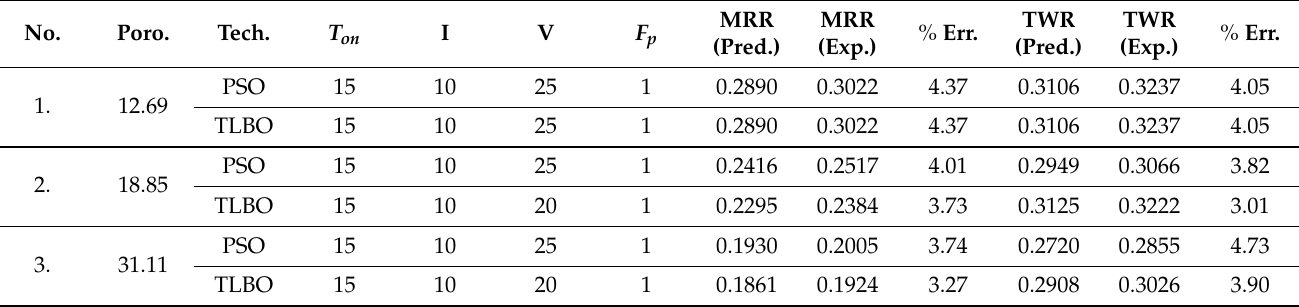
Table 9. Optimization results using TLBO and PSO for MRR and